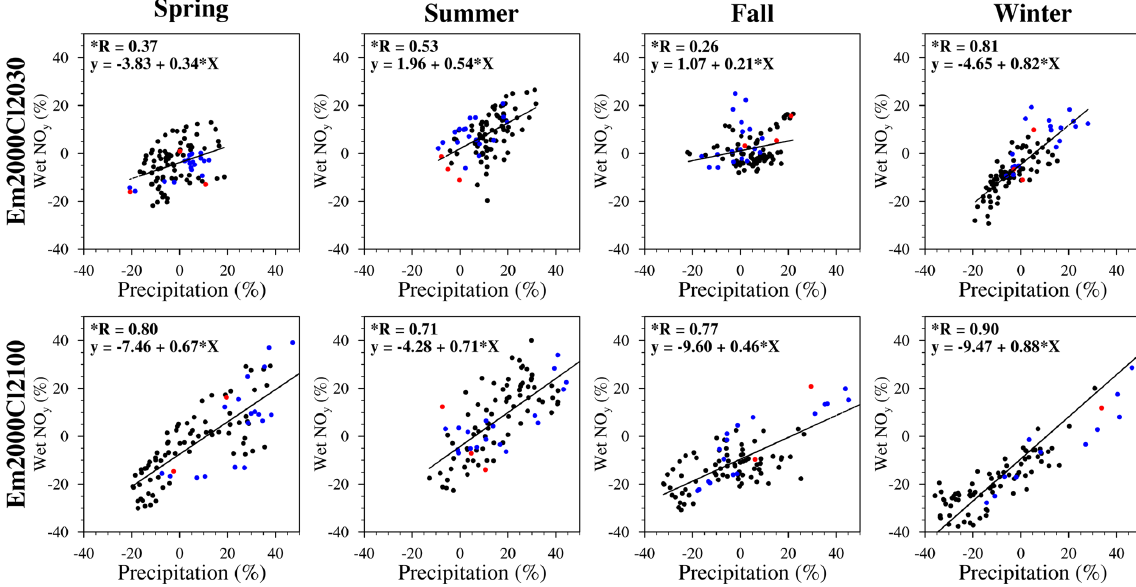
Figure 5. Comparison between precipitation and wet NO y deposition changes under the experimental scenarios of ACCMIP (Em2000Cl2030 and Em2000Cl2100) relative to the historical period (2001–2010) over the Bohai Sea (red points), Yellow Sea (blue points) and East China Sea (black points). An r test ( α = 0 . 05) is performed in each panel for statistical significance and the star before “R” indicates statistical significance at the 95% confidence level. Each point in this figure corresponds to the results from an individual model of ACCMIP.